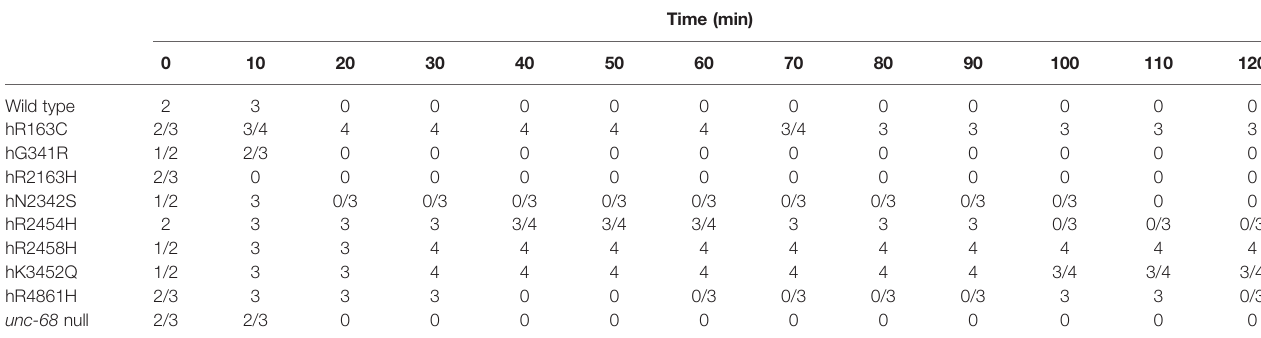
TABLE 3 | Response of ryanodine receptor (RyR) variant strains, identi fi ed by the human variant they correspond to, and of the N2 wild type and the CB540 unc-68 (e540 ) null mutant, to 1 mM levamisole in M9 buffer over 2